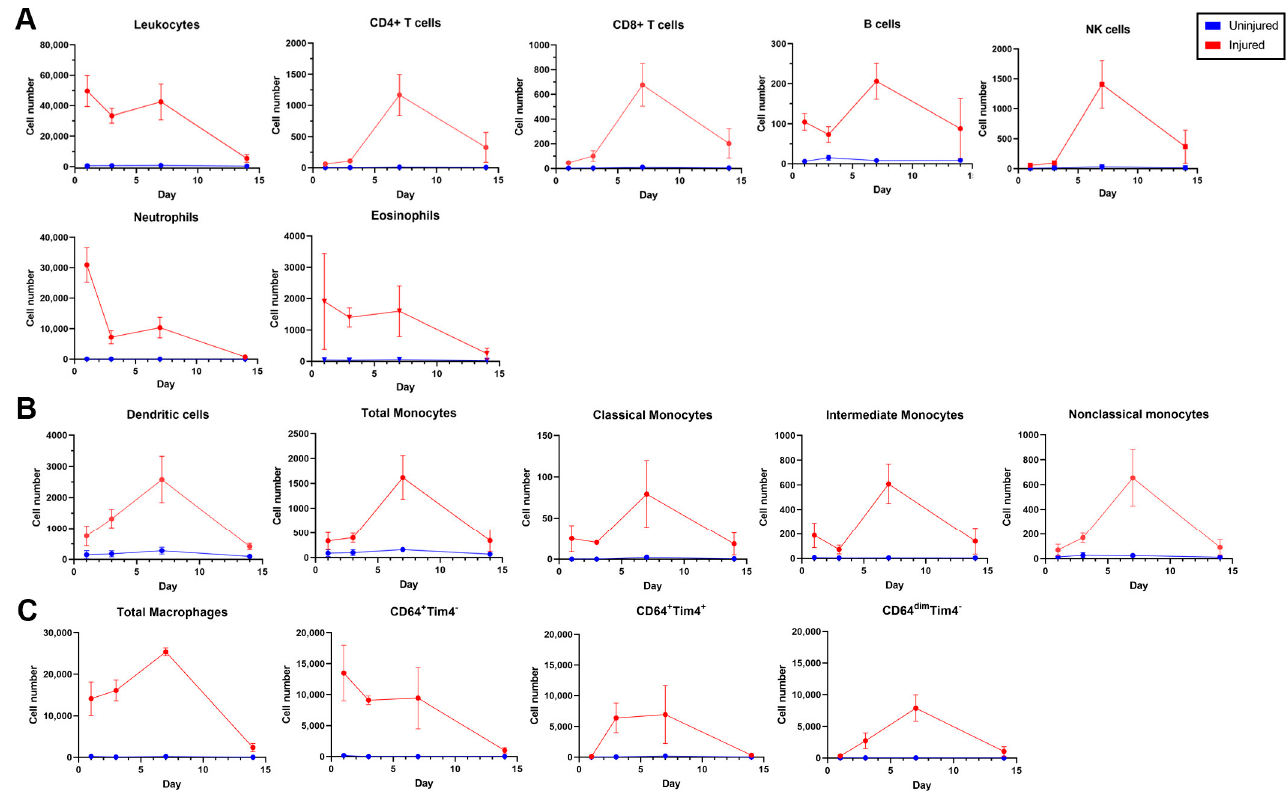
Figure 4. Leukocyte and leukocyte sub-population infiltration in uninjured arteries and at 1, 3, 7, and 14 days after injury using the high-parameter flow cytometry panel. Line graphs show all leukocytes, lymphocytes, neutrophils, natural killer (NK) cells, and eosinophils in injured and uninjured arteries ( A ), dendritic cells, monocytes, and monocyte sub-populations ( B ), and macrophages and macrophage subpopulations ( C ).